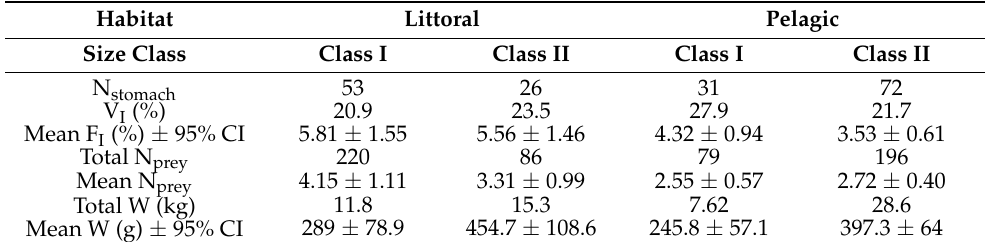
Table 2. Feeding intensity (as Vacuity index, V I %) and amount of food ingested (as Fullness index, F I %) together with the number and biomass of prey of the two size classes (Class I < 100 cm and Class II > 100 cm) of catfish caught in littoral and pelagic habitats of L. Maggiore. Habitat Littoral